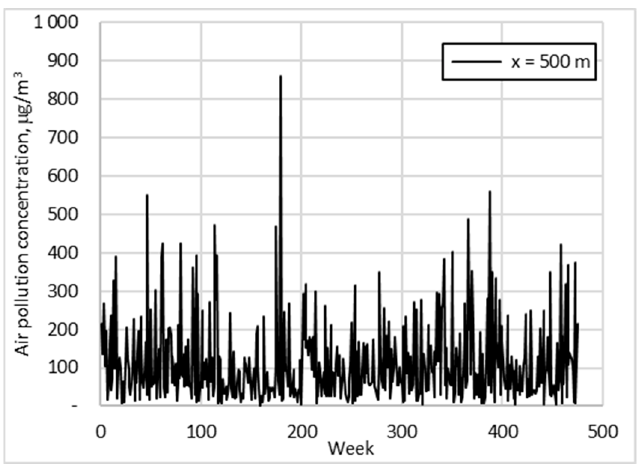
Figure 13. Monte Carlo air pollution generation for x = 500 m, NO x